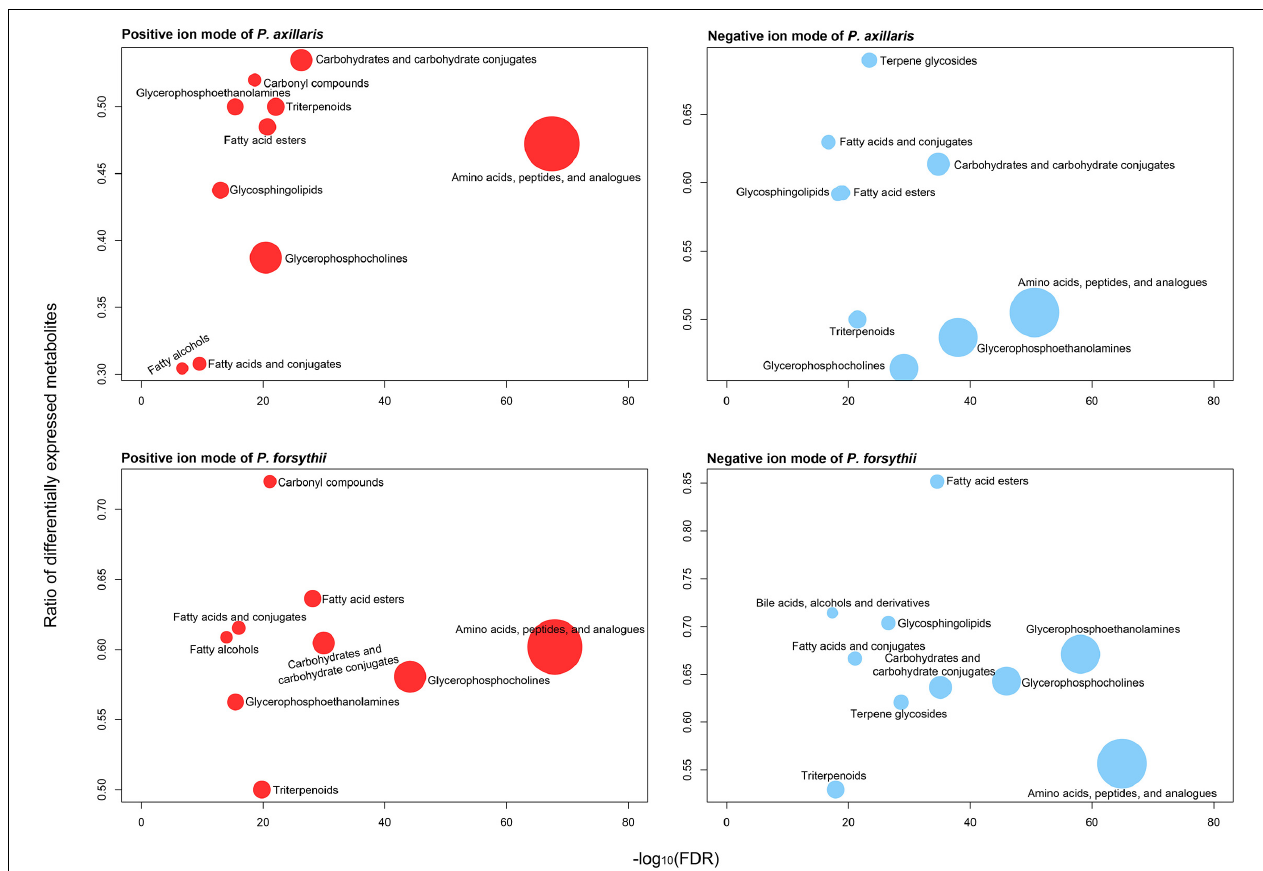
FIGURE 3 | Plasticity in main biochemical clusters of metabolites identified in metabolome assay. Red color denotes metabolites from positive ion mode, and blue color denotes metabolites from negative ion mode. The top panels represent the metabolome in P. axillaris , and the bottom panels represent that in P. forsythii .